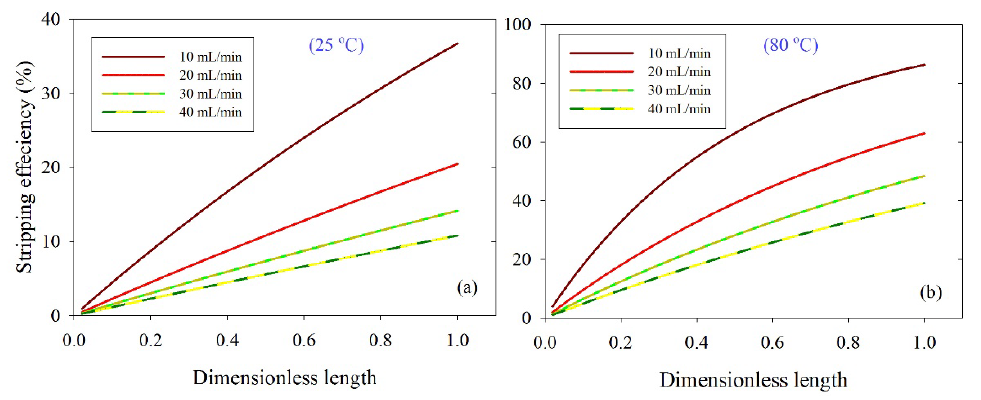
Figure 7. Effect of solvent circulation rate versus module dimensionless length on solvent stripping efficiency at gas flow rate 100 mL/min, and solvent temperatures 25 °C ( a ) and 80 °C ( b ).